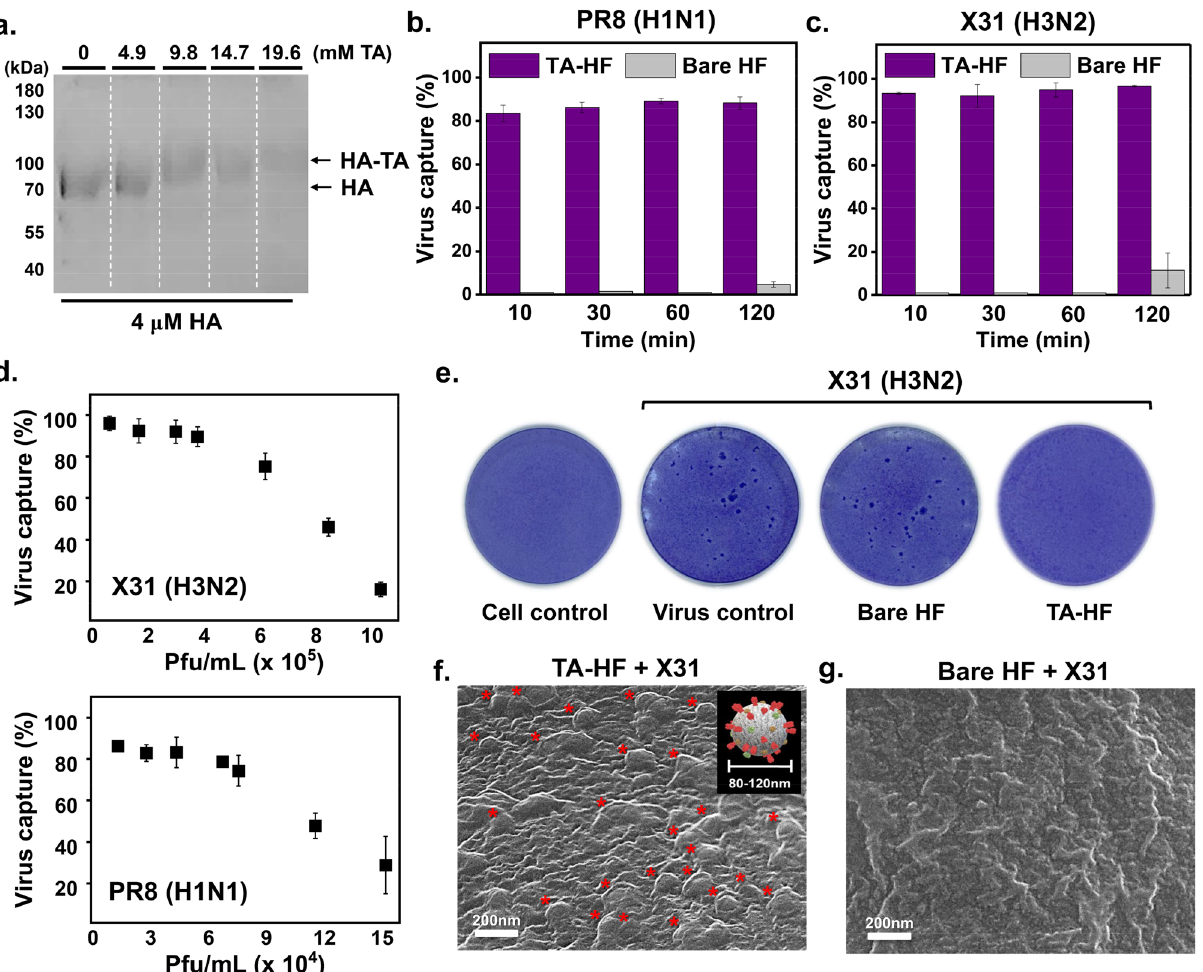
Figure 3. Influenza virus capture efficiency of TA-HF. (a) SDS-PAGE of hemagglutinin (HA: H1N1) pre- treated with different concentrations of TA (0–19.6 mM). HA (4 μM) was treated with TA for 2 h at 22 °C. (b,c) Influenza A virus (IAV) capture (%) by TA-HF and bare HF after 10, 30, 60, and 120 min incubation with PR8 (H1N1) (b) and X31 (H3N2). Viral titer was measured by the MUNANA assay. (d) IAV capture (%) by TA-HF and bare HF after incubation with different concentrations of X31 (top) and PR8 (bottom). (e) Evaluation of the virus capture efficiency of the bare HF and TA-HF by plaque reduction assay. MDCK cells were incubated with X31, which had been incubated with TA-HF, bare HF, or left untreated (virus control). (f,g) SEM images of the TA-HF (f) and bare HF (g) after incubation with X31. TA tannic acid, HF high-efficiency particulate air filter, SEM scanning electron microscopy, IAV influenza A